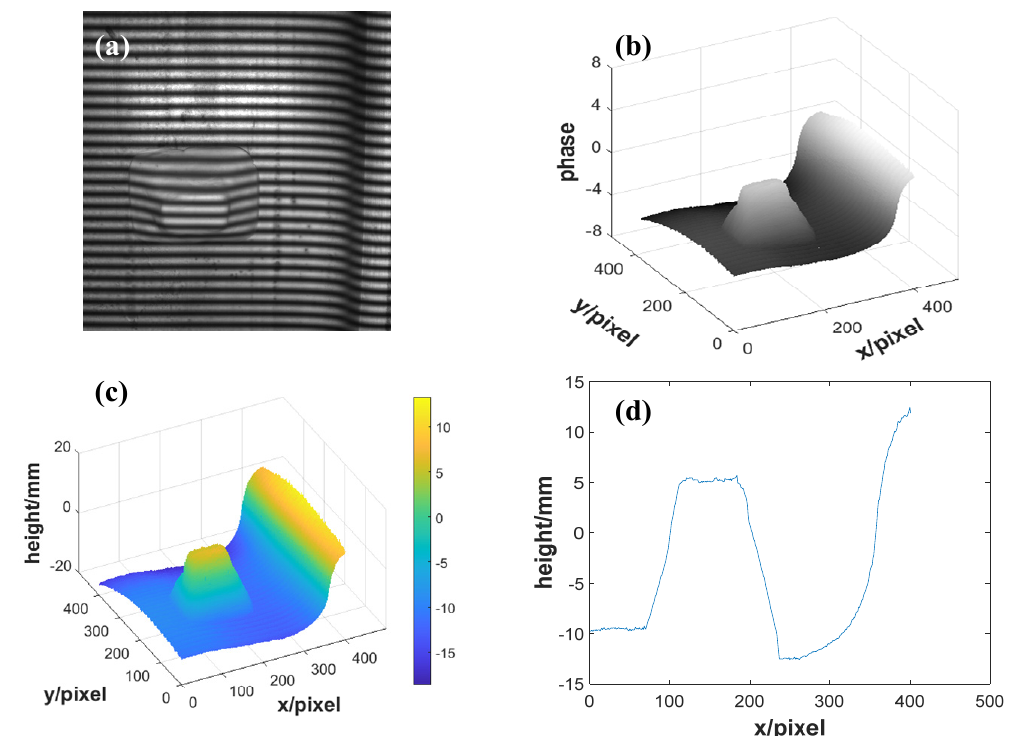
Figure 6. Wheel tread attached with a block: ( a ) deformed fringe pattern; ( b ) unwrapped phase by improved Stoilov algorithm; ( c ) 3D reconstruction of the wheel tread attached with a block; ( d ) height data of column 256 in ( c ).